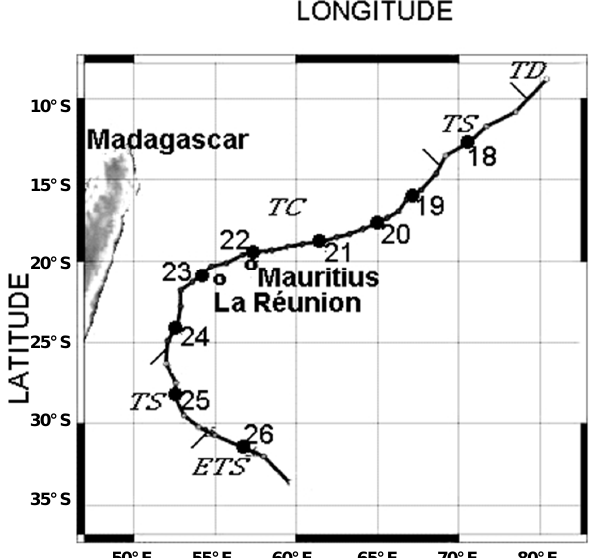
Fig. 1. Track of intense tropical cyclone Dina from 17 til 26 Jan- uary 2002; symbols TD, TS, TC, and ETS denote tropical depres- sion, tropical storm, tropical cyclone, and extratropical storm stages (adapted with permission from RSMC La R´eunion/M´et´eo-France).